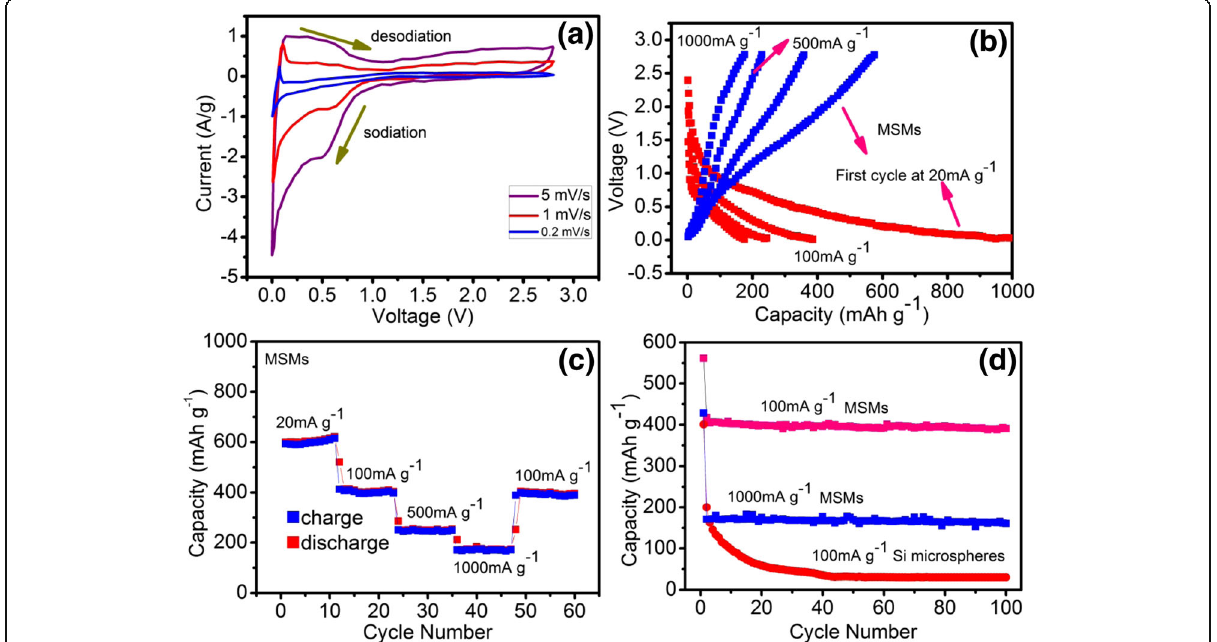
Fig. 3 a Cyclic voltammetry measurements of MSMs at different current density, b representative charge – discharge curves of MSMs at